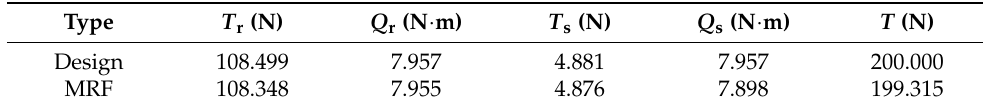
Table 7. Performance comparison of the redesigned 400 ducted fan.